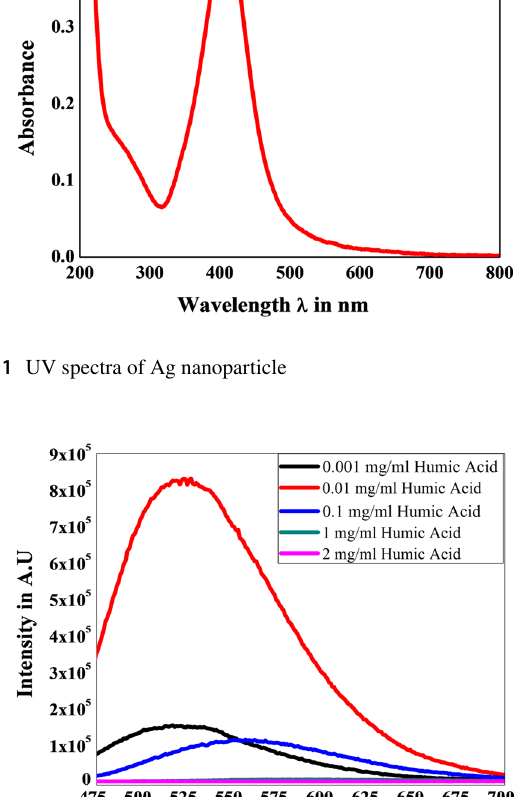
ex = 455 nm) of HA at different dilu-